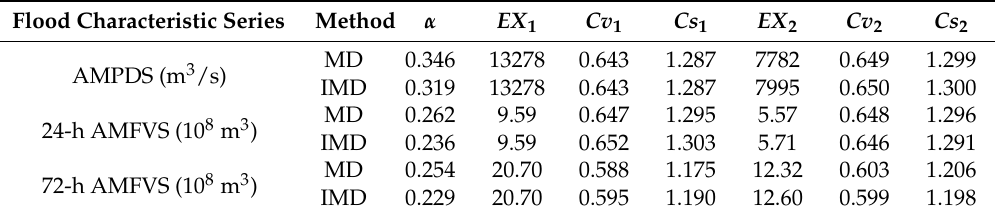
Table 11. Parameter estimation results for the mixed distribution (MD) and improved mixed distribution (IMD)